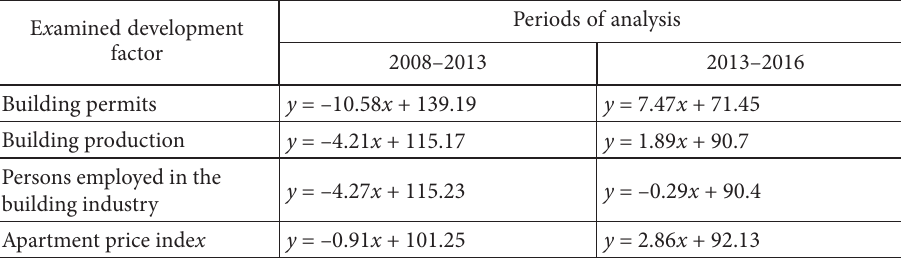
Table 1. The regression functions estimated for two periods of analysis, i.e. for years 2008 and 2013 and 2013 and 2016, for the e x amined development factors (source: author’s own study)